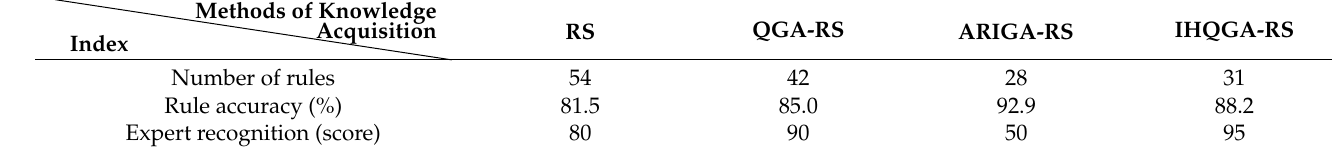
Table 11. Comparison of knowledge acquisition results.